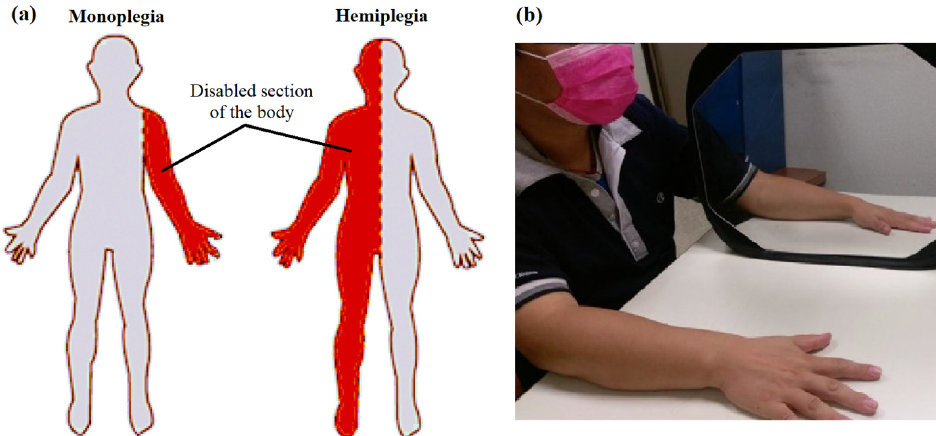
Figure 2. ( a ) Illustration of monoplegia and hemiplegia medical conditions; ( b ) Indicative image of a traditional MT configuration for hand rehabilitation [26]. traditional MT configuration for hand rehabilitation